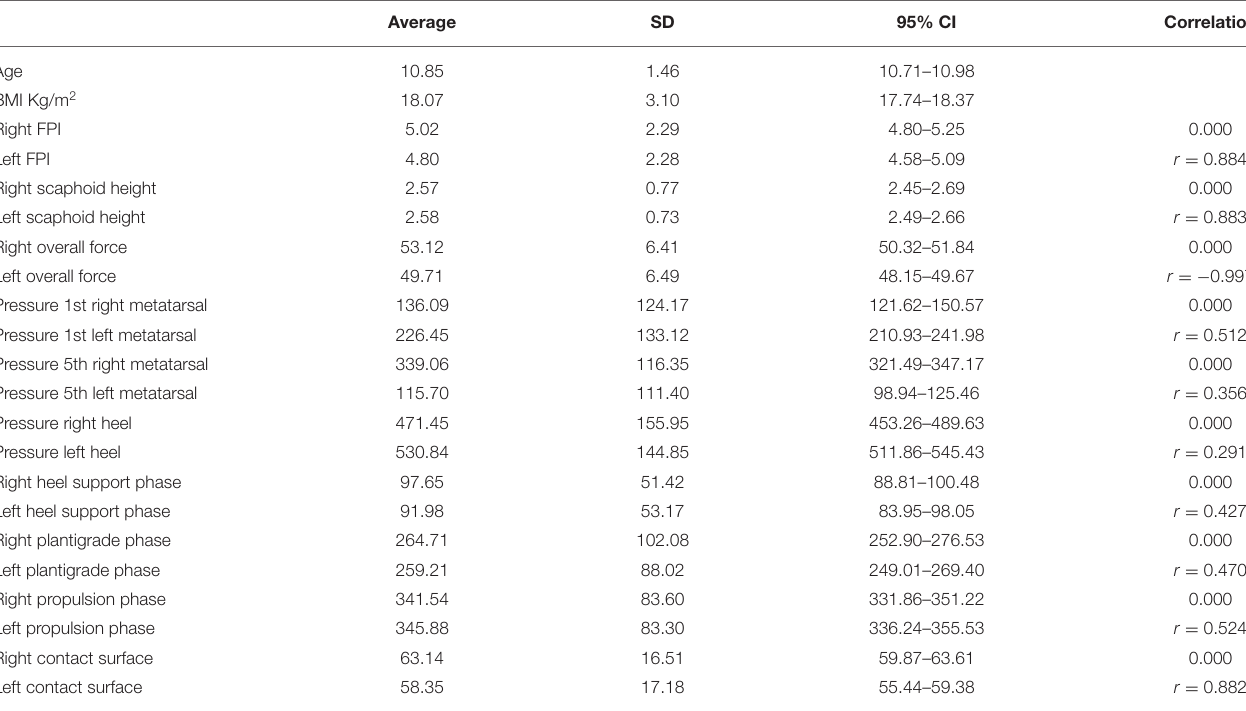
TABLE 1 | Anthropometric data and foot